Question: Condense the content of this figure into a single sentence.
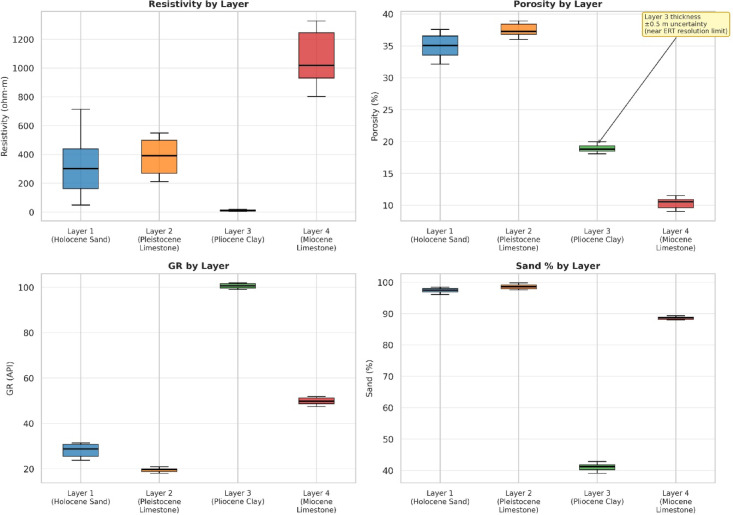
Answer: Box-plot distributions of key petrophysical and geophysical parameters across the four principal geoelectrical layers at Ras El-Hekma ( n = 87 borehole–ERT stations). Panels show: ( a ) electrical resistivity (ohm·m); ( b ) porosity (%); ( c ) natural gamma ray, GR (API); and ( d ) sand content (%). Sand content is expressed in percentage (%) in all panels; the y-axis in earlier versions showing fractional values (0–1) has been corrected. Box limits represent the interquartile range (IQR, 25th–75th percentile); the central line denotes the median; whiskers extend to 1.5 × IQR; open circles denote outliers. Note on Layer 3 (Pliocene Clay): reported thickness values carry an estimated uncertainty of ± 0.5 m, reflecting the resolution limit of the 10 m electrode spacing at depths exceeding 15 m; borehole core data provide the primary thickness constraint. Produced using Python (Https://matplotlib.org/; https://seaborn.pydata.org/tutorial/function_overview.html).